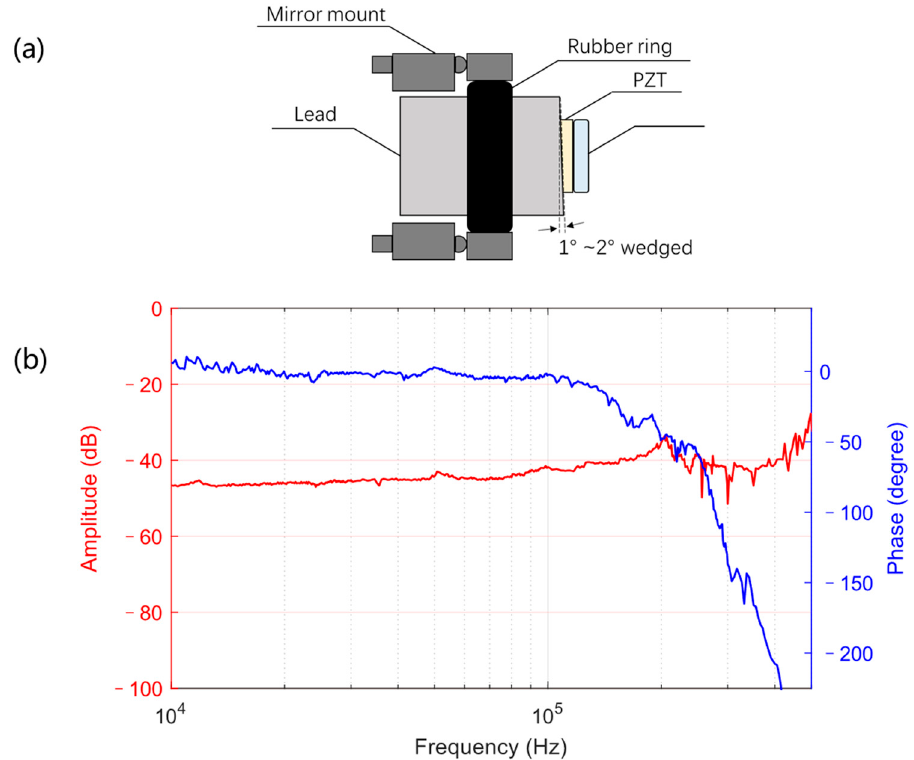
Figure 3. Design of our fast PZT system ( a ) and its frequency response ( b ). The mirror mount used here is Newport Suprema SN050-F3. The edge around the clear aperture of the mount is worn off to hold the rubber ring and lead.